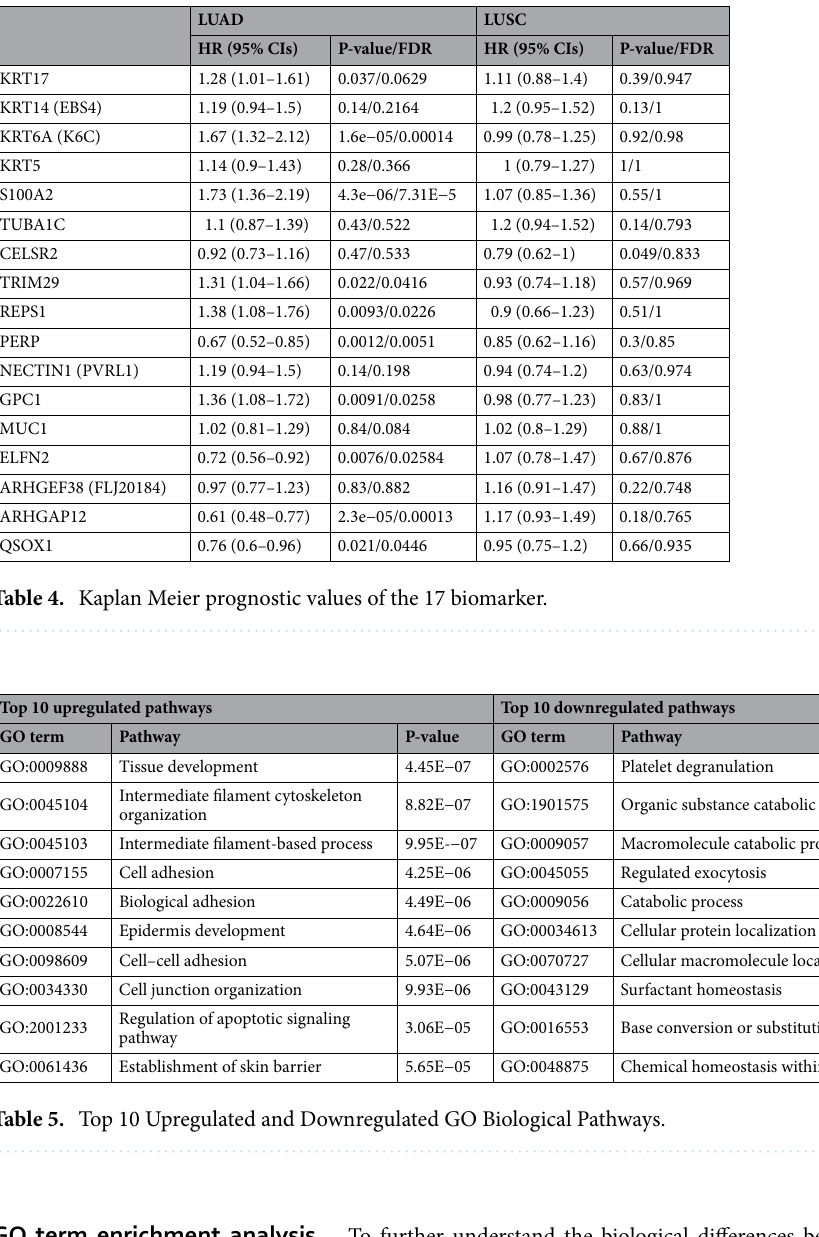
Table 5. Top 10 Upregulated and Downregulated GO Biological Pathways.